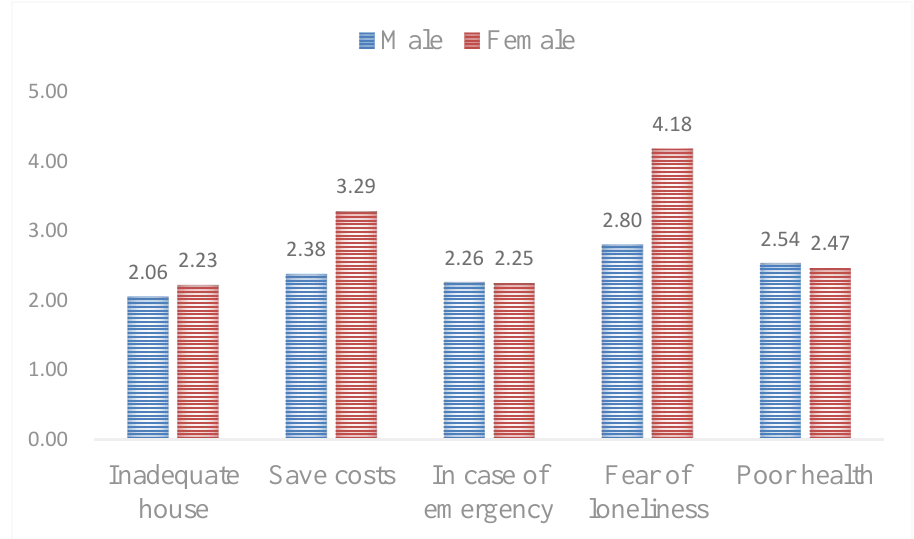
Figure 4. Intergenerational factors in different genders.